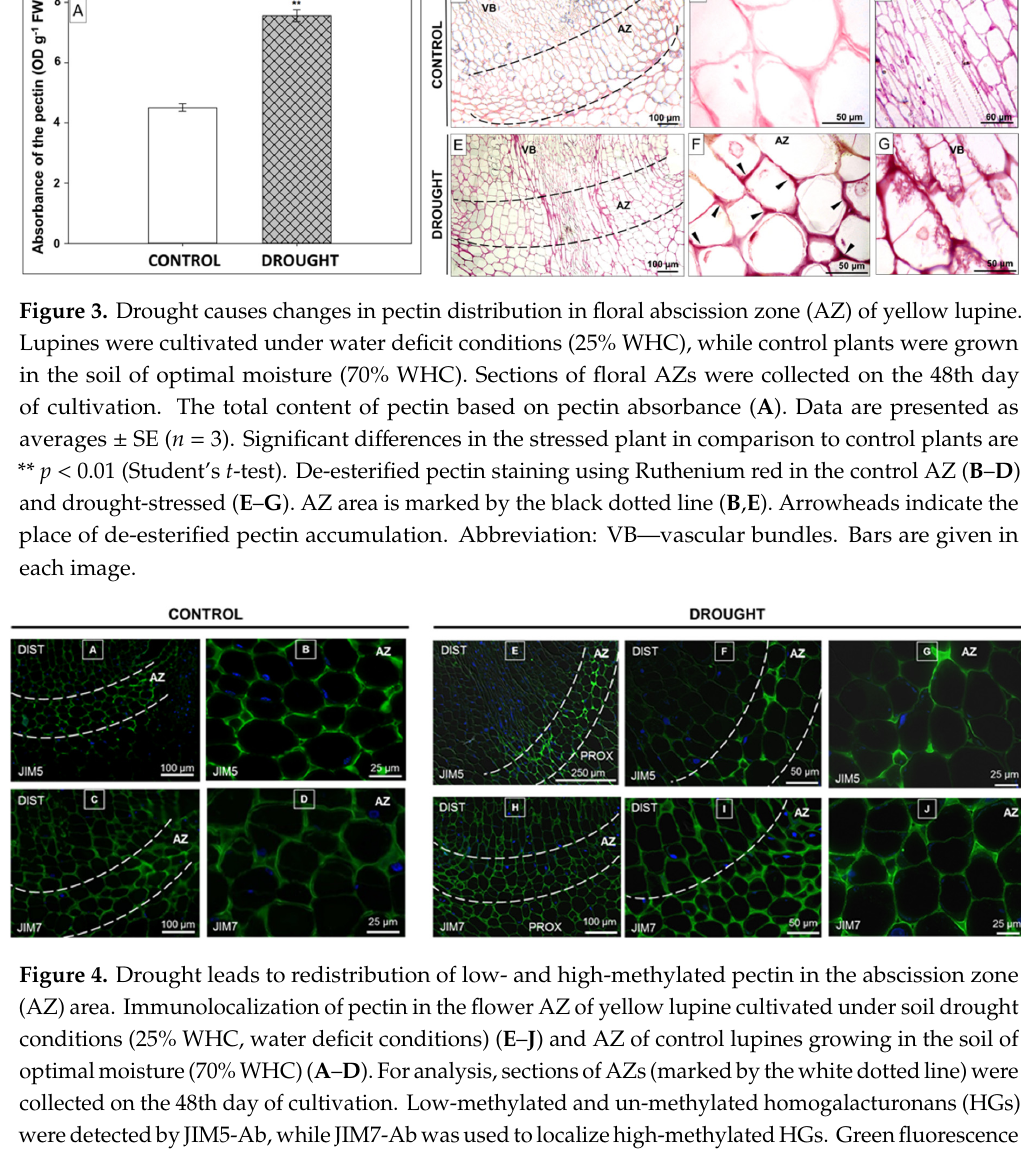
Figure 3. Drought causes changes in pectin distribution in floral abscission zone (AZ) of yellow lupine. Lupines were cultivated under water deficit conditions (25% WHC), while control plants were grown in the soil of optimal moisture (70% WHC). Sections of floral AZs were collected on the 48th day of cultivation. The total content of pectin based on pectin absorbance ( A ). Data are presented as averages ± SE ( n = 3). Significant differences in the stressed plant in comparison to control plants are ** p < 0.01 (Student’s t -test). De-esterified pectin staining using Ruthenium red in the control AZ ( B – D ) and drought-stressed ( E – G ). AZ area is marked by the black dotted line ( B , E ). Arrowheads indicate the place of de-esterified pectin accumulation. Abbreviation: VB—vascular bundles. Bars are given in each image.